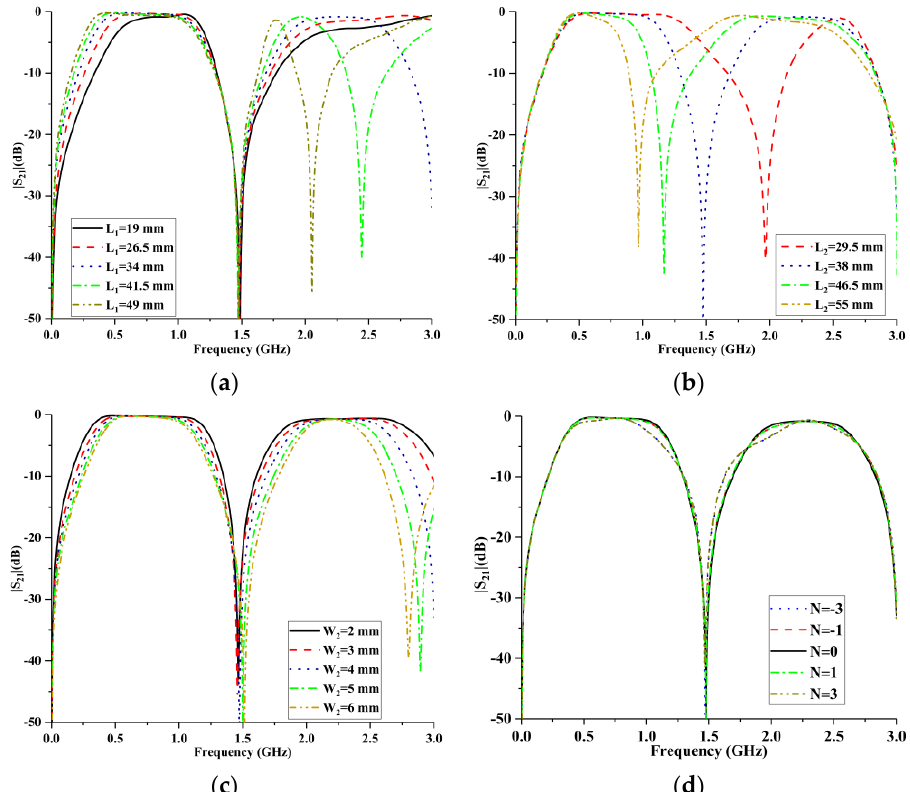
Figure 7. Simulated S 21 of the first-order dual-band bandpass filter with different combined-stub dual-mode resonator parameters. ( a ) Simulated S 21 of the first-order dual-band bandpass filter with different L 1 , L 2 = 38 mm, and W 2 = 4 mm. ( b ) Simulated S 21 of the first-order dual-band bandpass filter with different L 2 , L 1 = 34 mm, and W 2 = 4 mm. ( c ) Simulated S 21 of the first-order dual-band bandpass filter with different W 2 , L 1 = 34 mm, and L 2 = 38 mm. ( d ) Simulated S21 of the first-order dual-band bandpass filter with different N, W 2 = 4 mm, L1 = 34 mm, and L2 = 38 mm ( W s 1 = W s 2 = W 2 ).